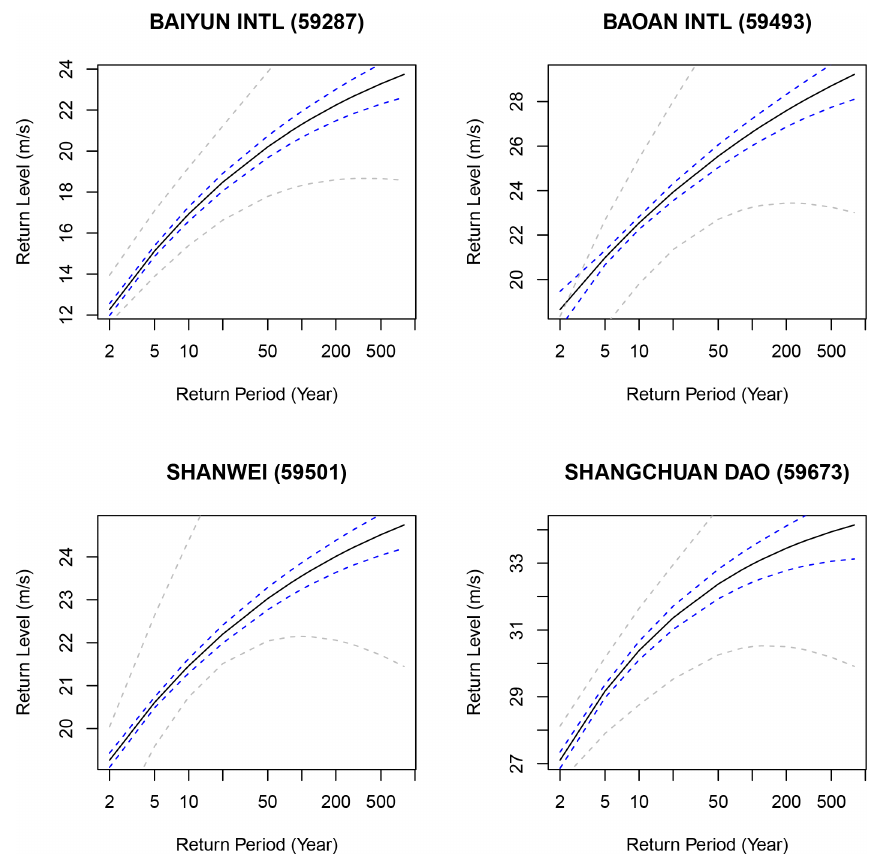
Figure 12. Return-period return level plots for four selected surface observation stations: Baiyun International Airport, Bao’an International Airport, Shanwei, and Shangchuan Dao. Black lines indicate the best estimate of return-period return level. Blue lines indicate the 95% confidence interval calculated using the TIGGE PEPS event set. Grey lines indicate the 95% confidence interval calculated using in situ